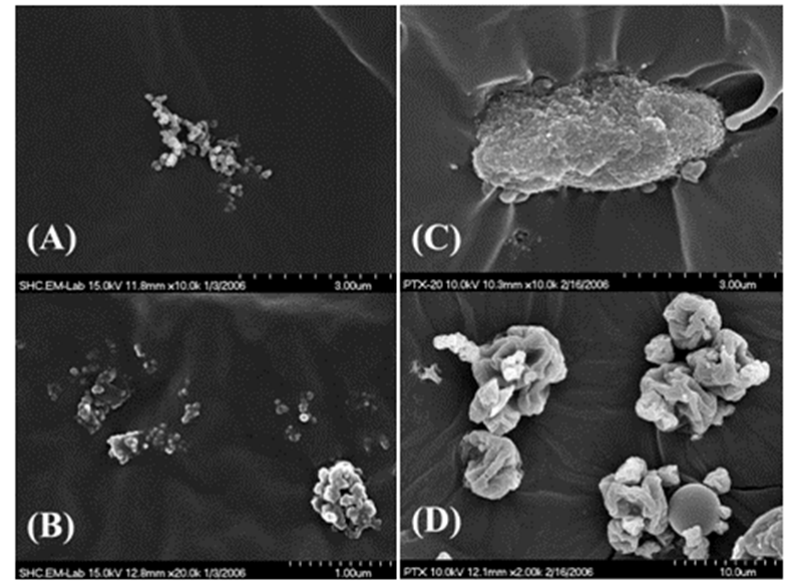
Figure 4. Scanning electron microscope (SEM) images of micro-aggregates formed in a paclitaxel (PTX)–polyurethane (PU) film on a cut surface ( A ) and on an air-dried surface ( B ) from a PTX–PU film with PTX at 5.4 wt %; Larger aggregate was found from a PTX–PU film with PTX wt % at 20% ( C ); Note that the aggregate morphologies are different from that of original PTX powder ( D ). (Reprinted with permission from [57], Copyright 2010 Springer).